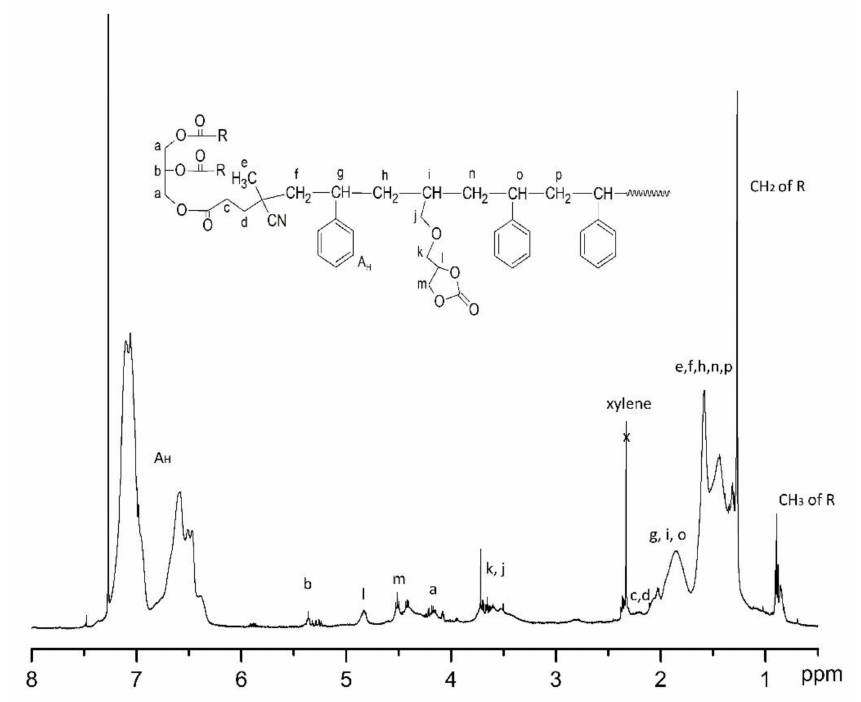
Figure 6. 1 H NMR spectrum of